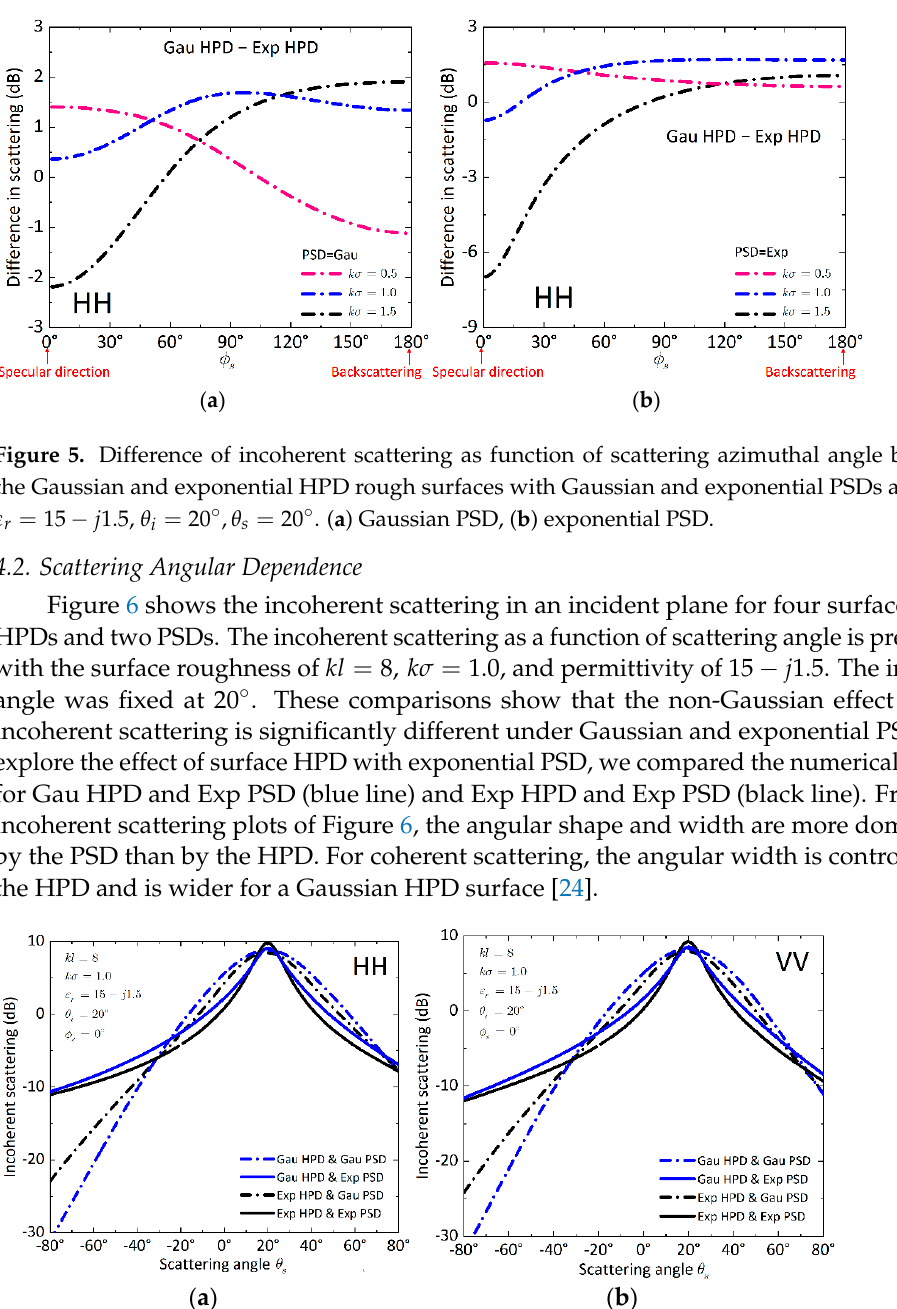
( b ) Figure 4. Difference of incoherent scattering as function of scattering angle between the Gaussian and exponential HPD rough surfaces with Gaussian and exponential PSDs at